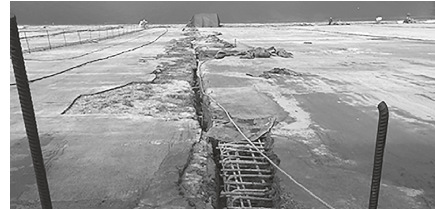
Figure 6: Extrusional deformation along the slab